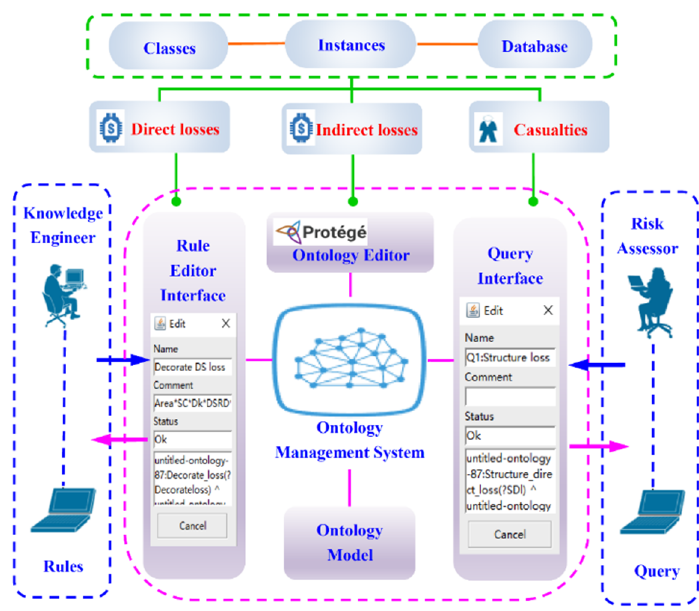
Figure 2. Schematic diagram of the OntoBSRA system.